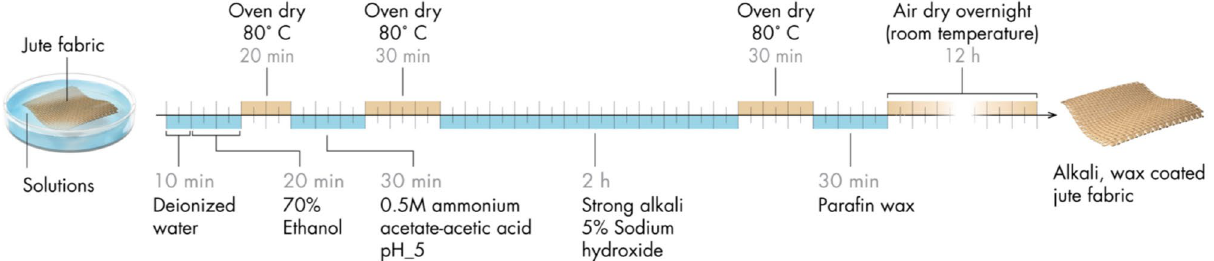
Figure 1. Schematic of the jute surface treatment process (image credits: Xavier Pita,